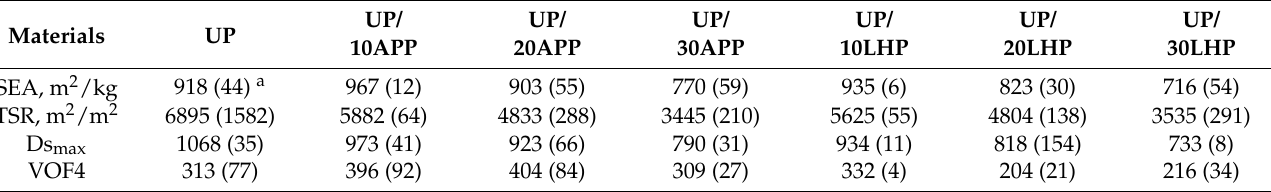
Table 5. Smoke emission of UP and